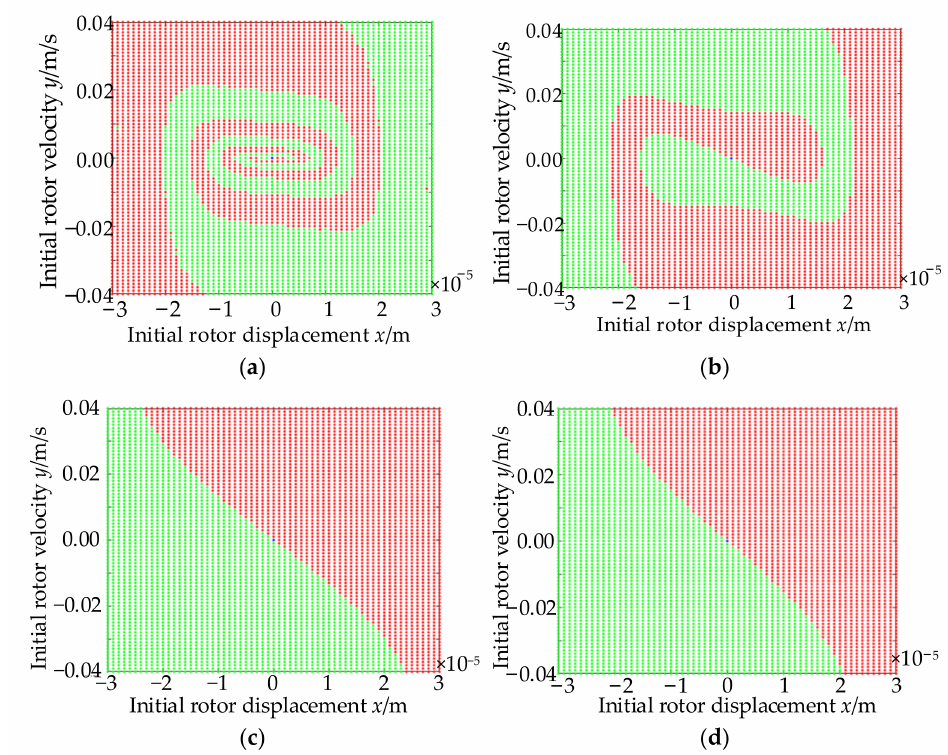
Figure 11. Photo of basin of attraction. ( a ) Basin of attraction when K p = − 60. ( b ) Basin of attraction when K p = − 30. ( c ) Basin of attraction when K p = 30. ( d ) Basin of attraction when K p =